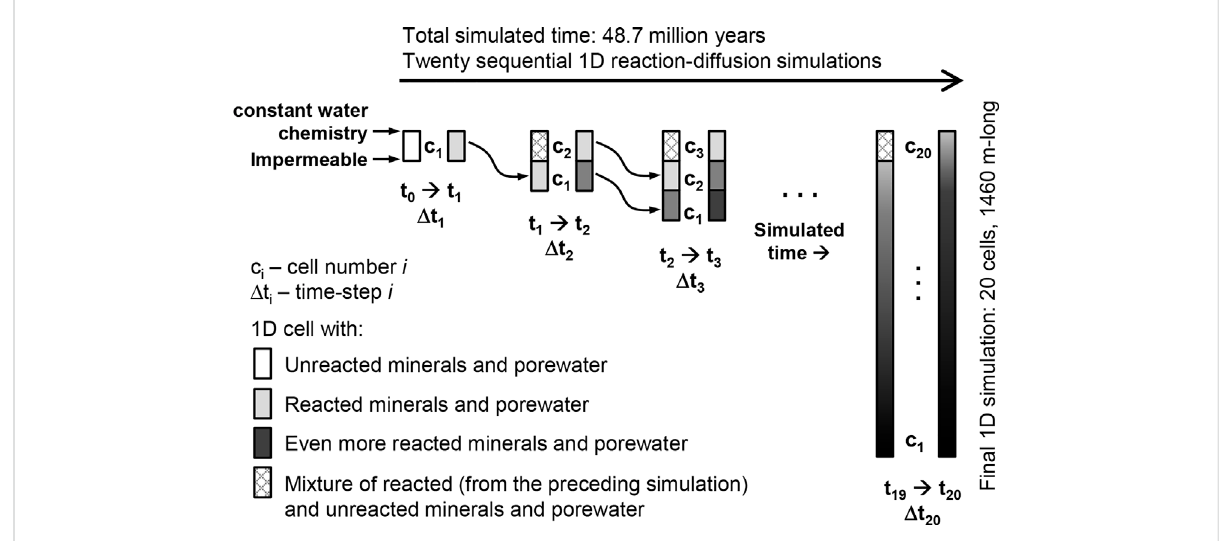
FIGURE 2 Illustration of the methodology implemented in PHREEQC for simulating the build-up of the sedimentary column, geochemical reactions and solutediffusionintheAmami-SankakuBasinfor48.7 Ma.Theboundaryconditionsareconstantatthetopofthecolumnandclosedatthebottomof the column for the twenty reaction-diffusion